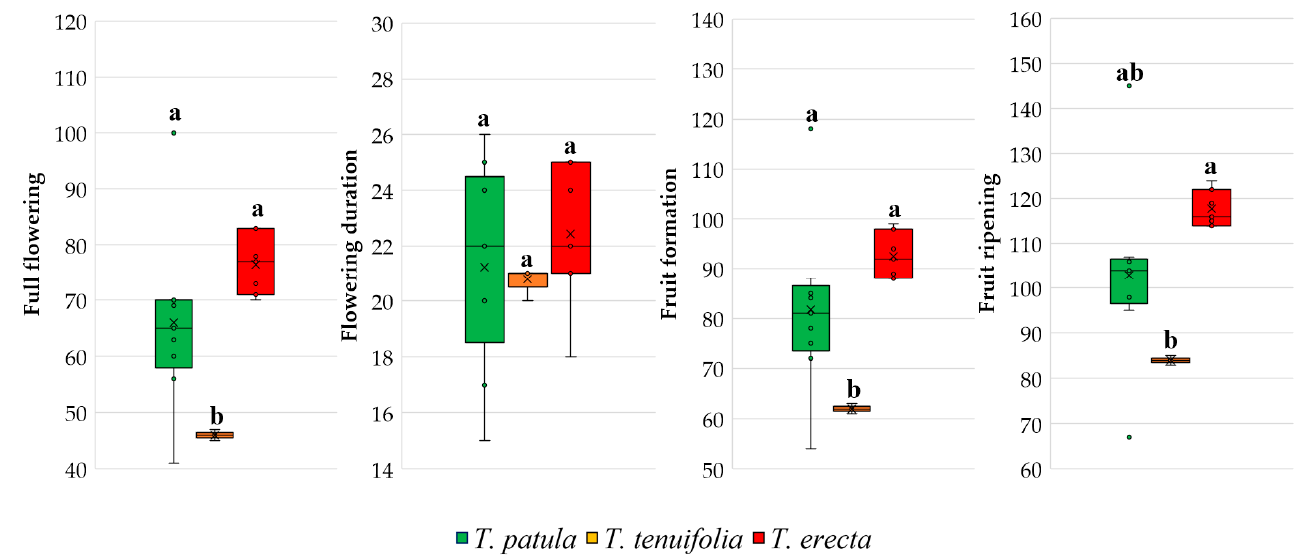
Figure 5. Main reproductive traits and phenophases based on the cultivars analysed in the three species of Tagetes . Each box plot represents minimum, lower quartile, median, upper quartile, and maximum values; in addition, the mean of the data is symbolised with a ‘ ✕ ’ into the boxplot. Different letters among boxplots indicate statistically significant differences for the respective trait at a significance level of p < 0.05 (Duncan’s test).